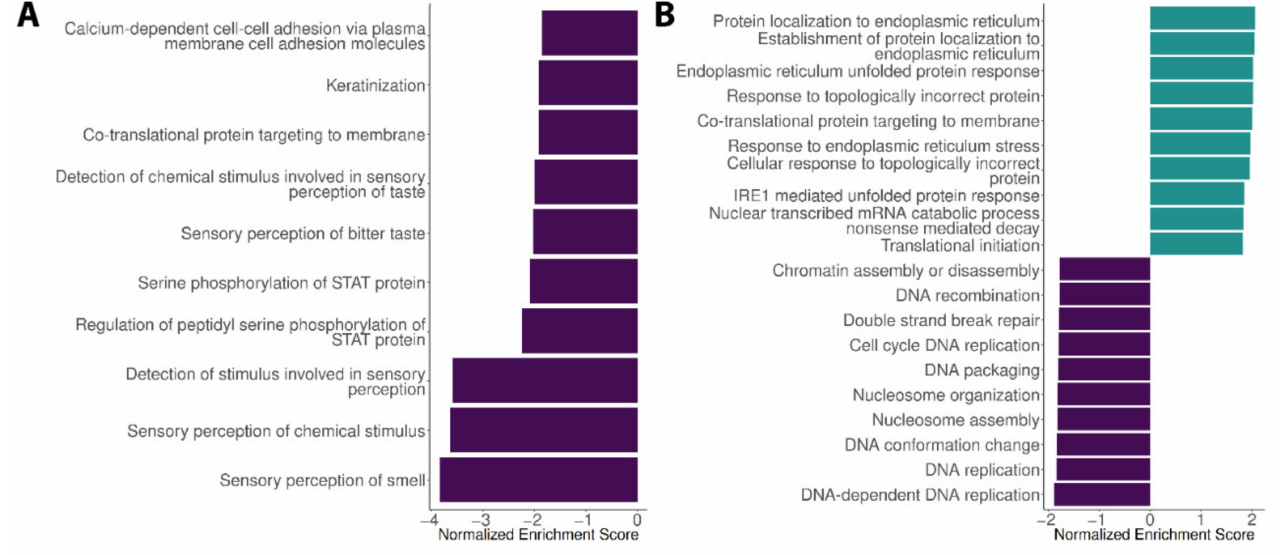
Figure 1. Top 20 Gene Ontology Biological Process (GO-BP) pathways in the ( A ) spleen and ( B ) liver cells (cut-off values: nominal p -value < 0.05 and FDR < 0.25). Positive normalized enrichment score (NES; in purple) represents upregulated pathways in the infected individuals versus controls, while negative NES values (in green) represent downregulated pathways in the infected individuals versus